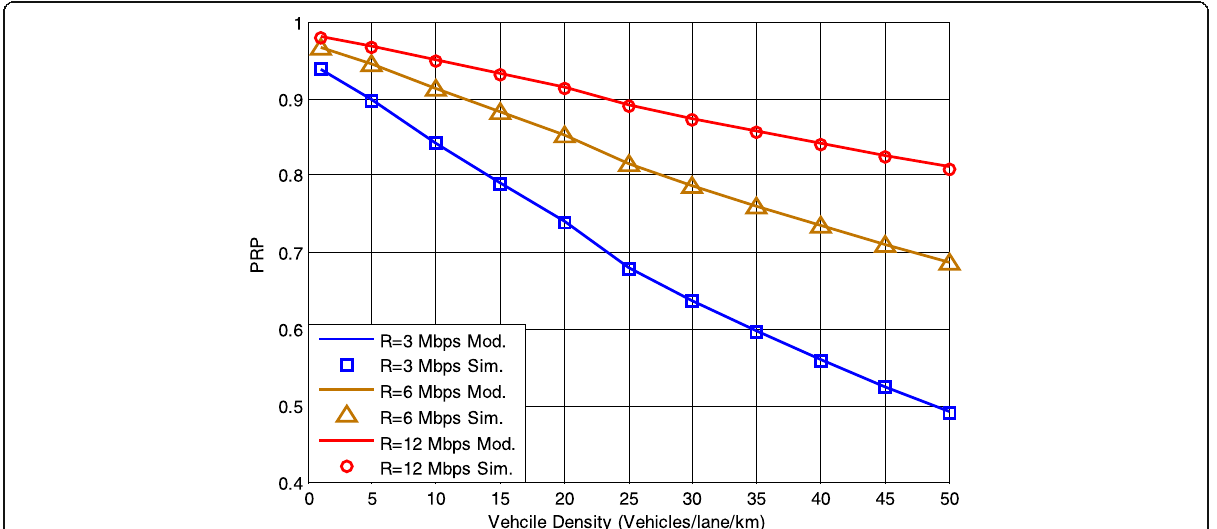
Fig. 15 Comparison of analytic model and simulation results of PRP with the hidden terminal collisions for data rates with respect to vehicle density, W 0 = 16, R c = 250 m, D = 186 B, λ = 10 Hz